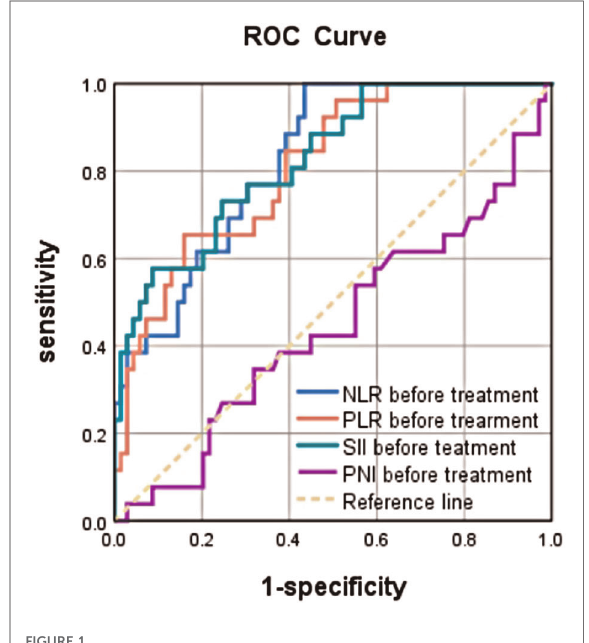
FIGURE 1 Predictive ability of the SII,NLR, PLR and PNI presented by ROC